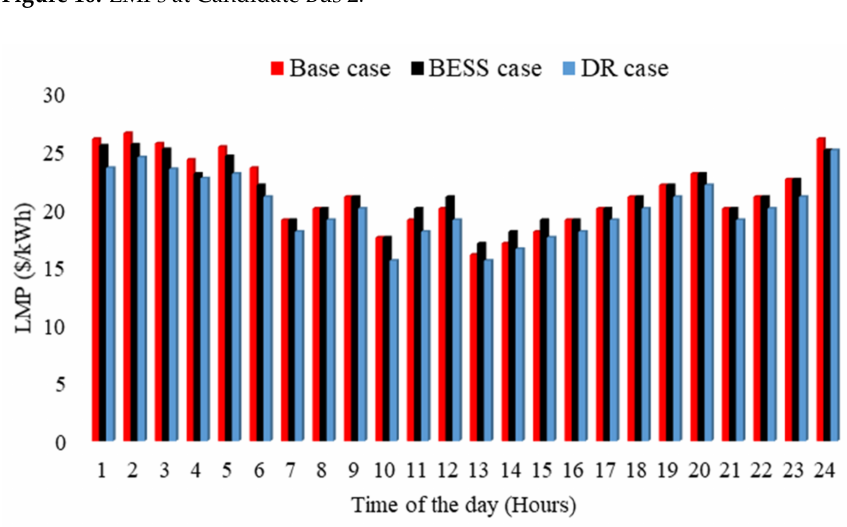
Figure 10. LMPs at Candidate Bus 2.